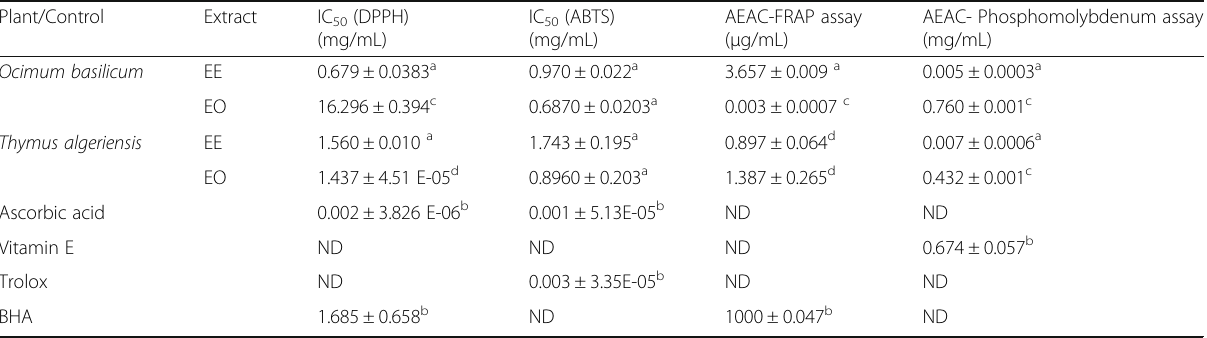
Table 4 IC 50 (DPPH), IC 50 (ABTS), AEAC (FRAP assay), AEAC (Phosphomolybdenum assay) of the extracts, ascorbic acid, and BHA